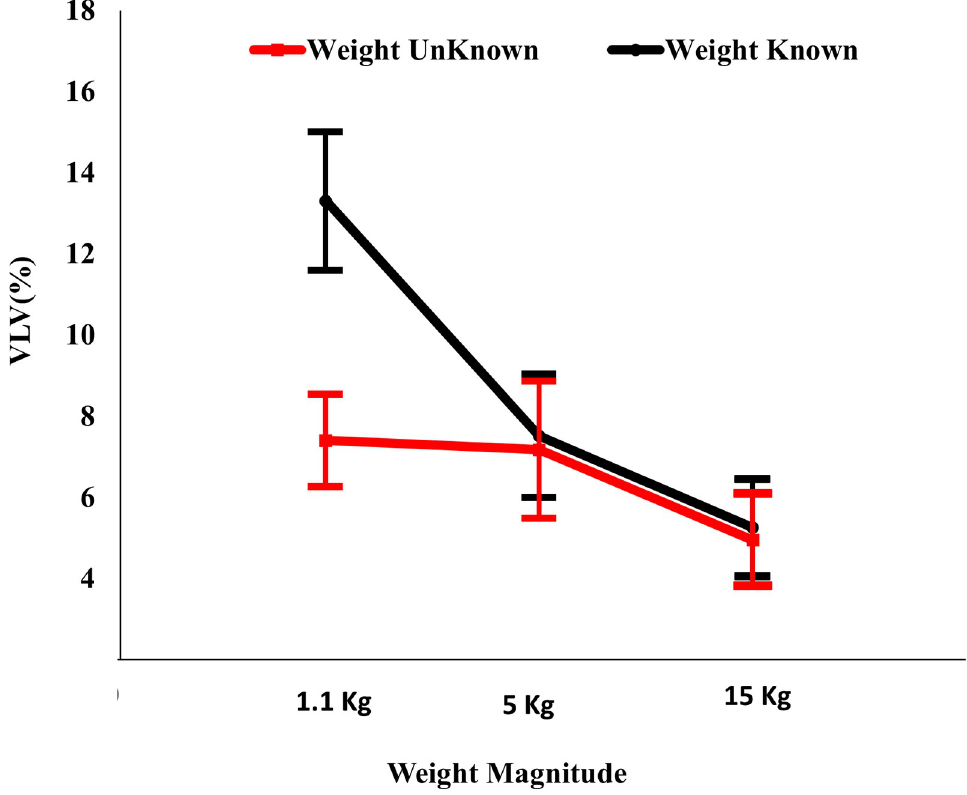
Fig 2. Effects of weight knowledge and weight magnitude on VLF power.